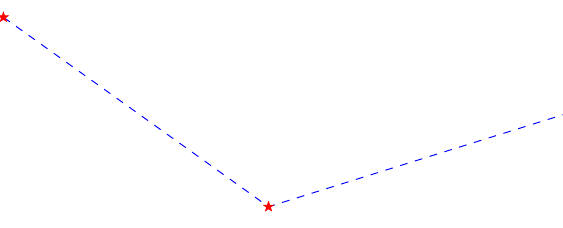
Figure 13: Initial path of two straight lines connecting three sequential waypoints on the